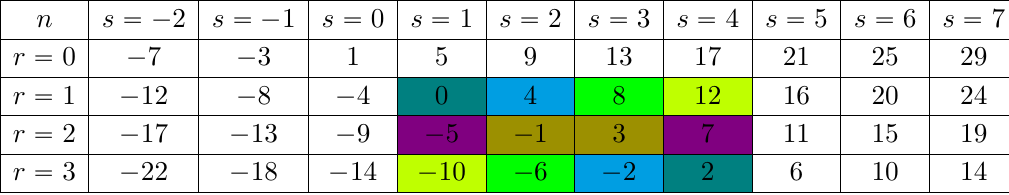
Table 4 . Values of the momentum n of some operators in the p 5 , 4 q compact linear dilaton.